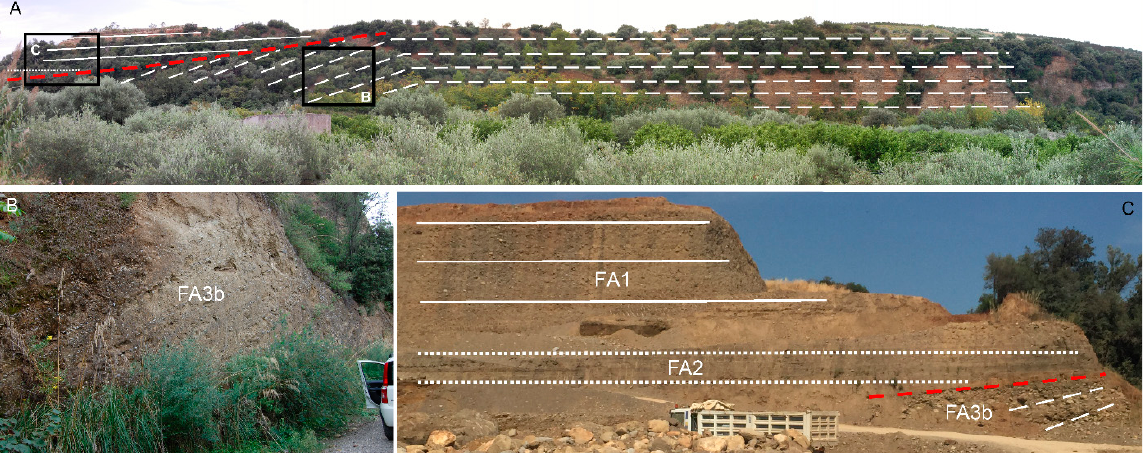
Figure 7. Overview ( A ) and details ( B , C ) of stratigraphic successions of the T4 terrace. Gilbert-delta (FA3b) conglomerates and sandstones ( A , B ) pass upward (red line) to beach sediments (FA2, dotted line) that are overlain ( C ) by fluvial deposits (FA1, solid line).